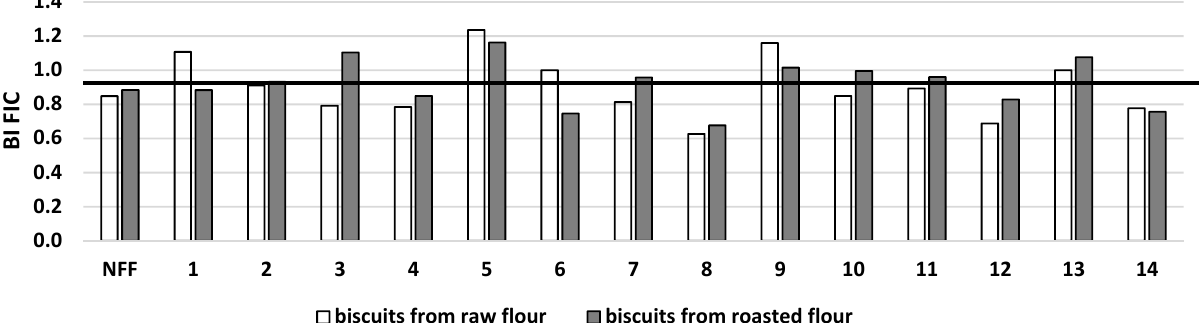
Figure 4. Potential bioaccessibility of free FIC (BI FIC) from buckwheat biscuits baked from raw or roasted buckwheat flour fermented by selected strains of lactic acid bacteria. NFF—nonfermented flour. Flours fermented by: 1 —Lactiplantibacillus plantarum IB; 2— Lactiplantibacillus plantarum W42; 3— Lactobacillus delbrucki subsp. bulgaricus 151; 4— Lacticaseibacillus casei Lcy; 5— Streptococcus thermophilus MK-10; 6— Lactobacillus acidophilus La5; 7— Lactobacillus acidophilus V; 8— Lactobacillus acidophilus 145; 9— Lacticaseibacillus casei 2K; 10— Lactobacillus delbrucki subsp. bulgaricus K; 11— Lacticaseibacillus rham- nosus GG; 12— Lacticaseibacillus rhamnosus 8/4; 13— Lacticaseibacillus rhamnosus K; 14— Ligilactobacillus salivarius AWH. BI > 1: high bioaccessibility; BI < 1: low bioaccessibility. The analysis of fluorescence associated with the presence of tryptophan in the buck- wheat biscuits (Table 1A,B) indicated a slight variation compared to the control